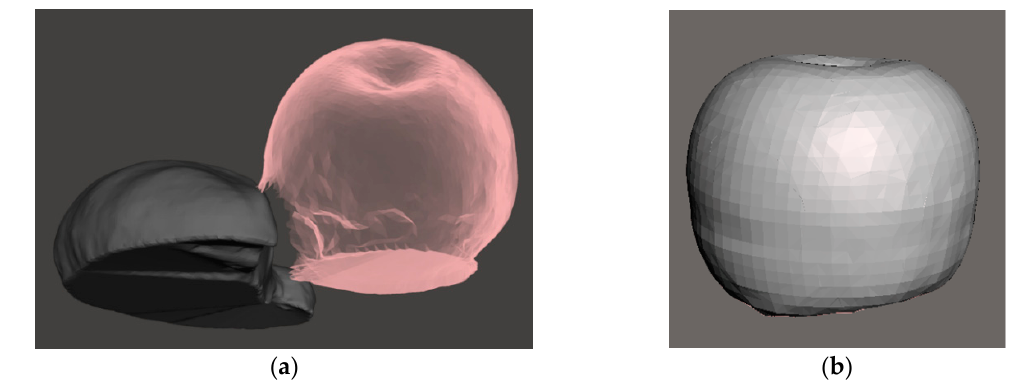
Figure 8. A 3D rendered mesh can produce significant errors if not handled well: ( a ) shows an apple and croissant captured together, which creates a hole during segmentation; ( b ) shows the corrected mesh for the apple after hole filling (14% error of underreporting in this specific case).